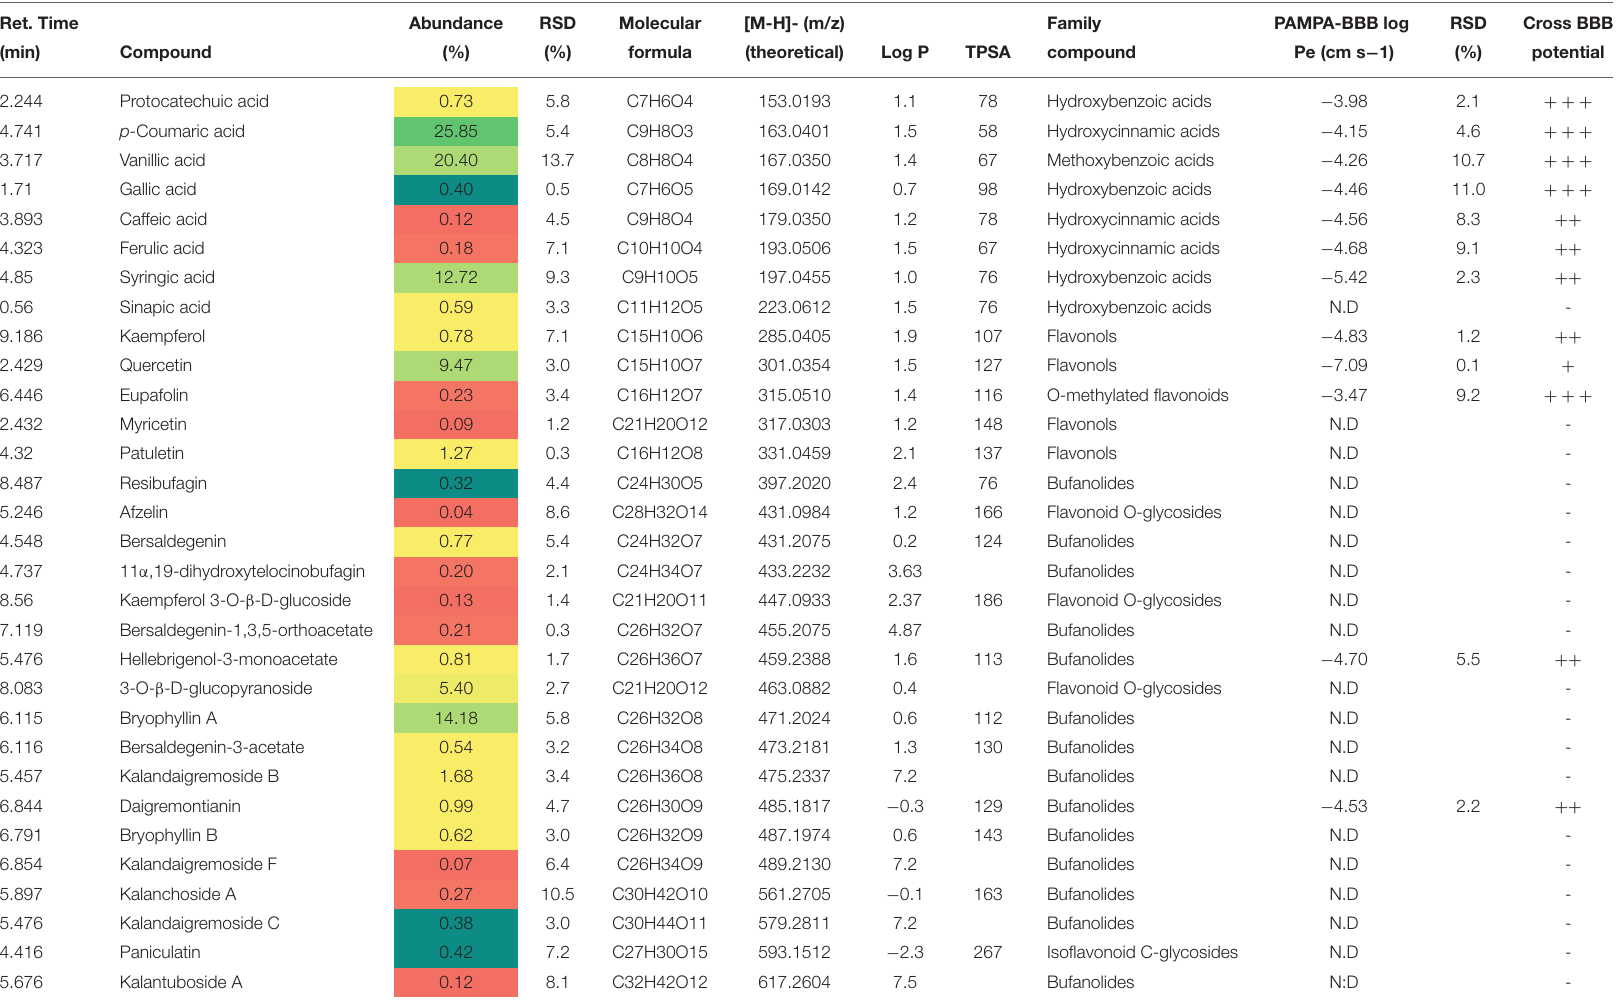
TABLE 2 | Phytochemical profile, abundance (%), and BBB permeability of KD (Kalanchoe daigremontiana, kalanchoe UAE extract). Ret.